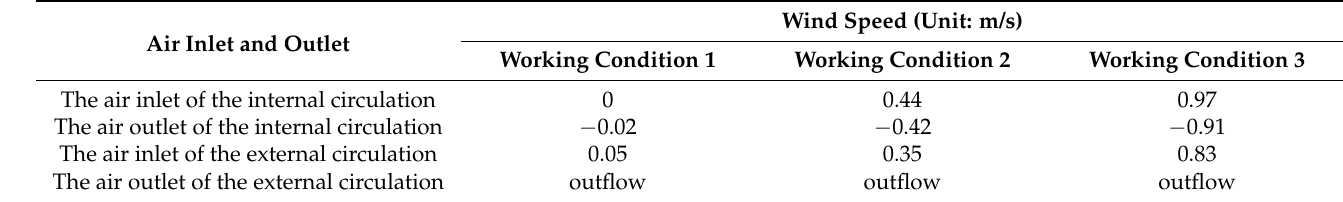
Table 6. Wind speed measurement at inlet and outlet of broiler chamber under different working